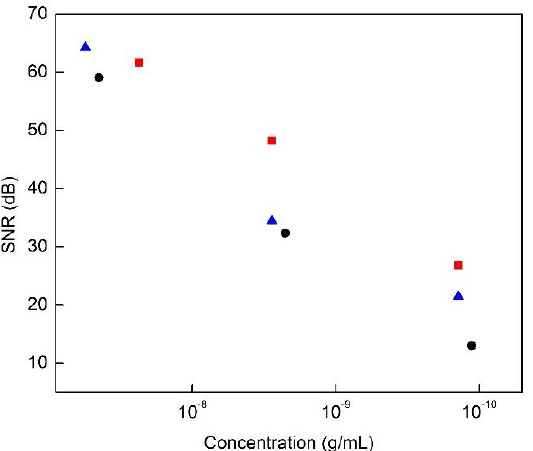
Figure 5. SNR of different concentrations of NiNWs: as-synthesized non-coated NiNWs (red-square), NiNW-Ag-gelatin (blue-triangle), and NiNW-gelatin (black-circle).